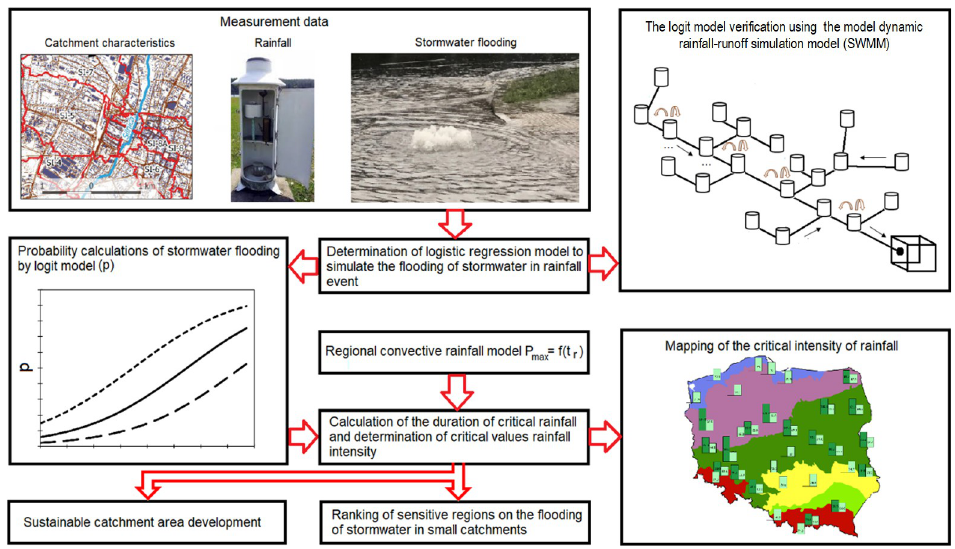
Fig 1. Calculation algorithm of the model used for analyzing the influences of the local catchment and rainfall characteristics on flooding in a small urban catchment.